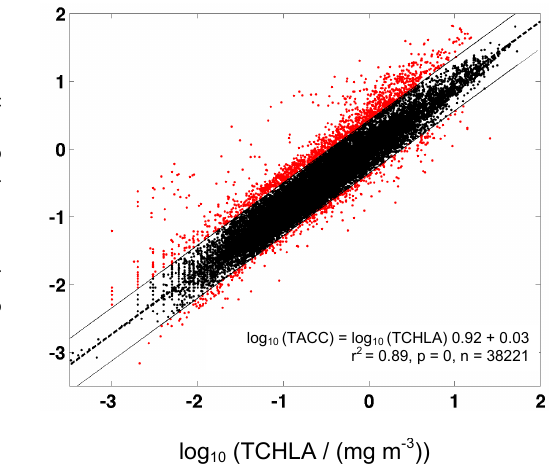
Figure 2. Linear relation between log-normalized total chloro- phyll a (TCHLA; mgm − 3 ) and total accessory pigment (TACC; mgm − 3 ) concentrations. Data ( n = 38221) are exclusive of samples already flagged for TCHLA values of zero, or for having less than four non-zero accessory pigments. The central dashed line is the fit (log 10 (TACC) = log 10 (TCHLA) (0.92) + 0.03; r 2 = 0 . 89, p = 0, n = 38221). Solid lines represent ± two standard deviations from the regression, beyond which outlying data points (shown in red) were flagged (“ F Rat ”, n =